Question: Generate an informative caption for the figure above.
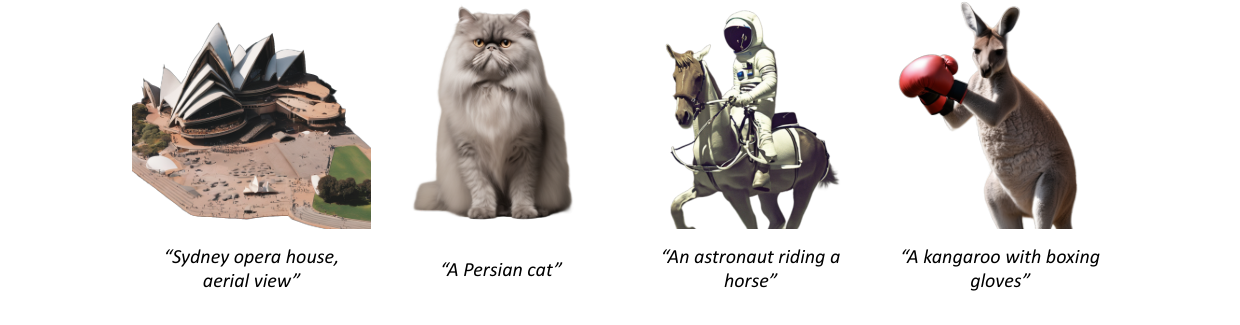
Answer: Reference images for image-to-3D works (Liu et al., 2023; Qian et al., 2023). These images are generated by Stable Diffusion (Rombach et al., 2022a), followed by processing such as background removal. In certain cases, we have observed results of image-to-3D methods that do not reach the quality of the qualitative results shown in their paper. We conjecture that this is due to the sensitivity of the input images generated from text-to-image models when they diverge from the domain of the training (or fine-tuning) dataset. In contrast, the results of text-to-3D tasks, including our results, seem not to encounter this issue; they bypass the specific reconstruction objectives of these input images and generate results that align well with the trained domain corresponding to the text.